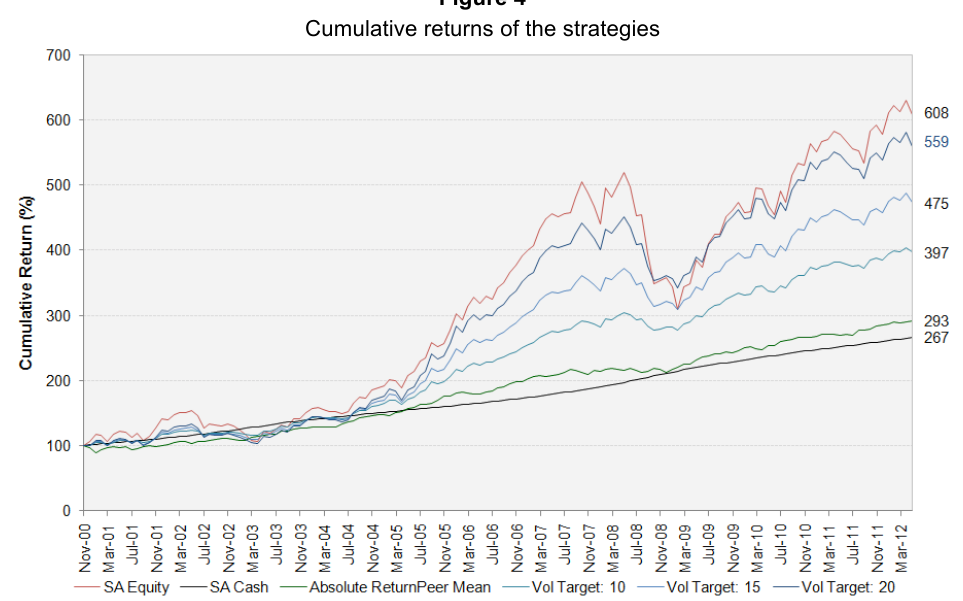
Cumulative returns of the